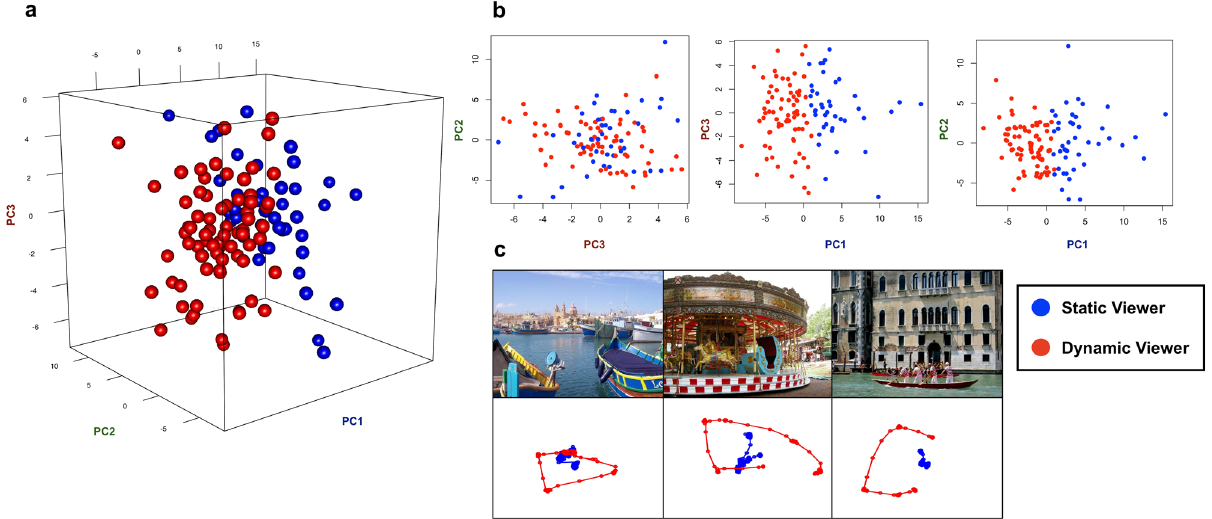
Fig. 3 Relation between clusters and principal components. a Clusters ’ projection in the three-dimensional space de fi ned by the fi rst three principal components. b Two-dimensional relation between PC scores. The values of PC1 are those best describing the two clusters; c Examples of Static and Dynamic eye-movements pattern (each dot represents gaze position sampled at a timepoint). Static viewers are represented in blue and Dynamic viewers in red.